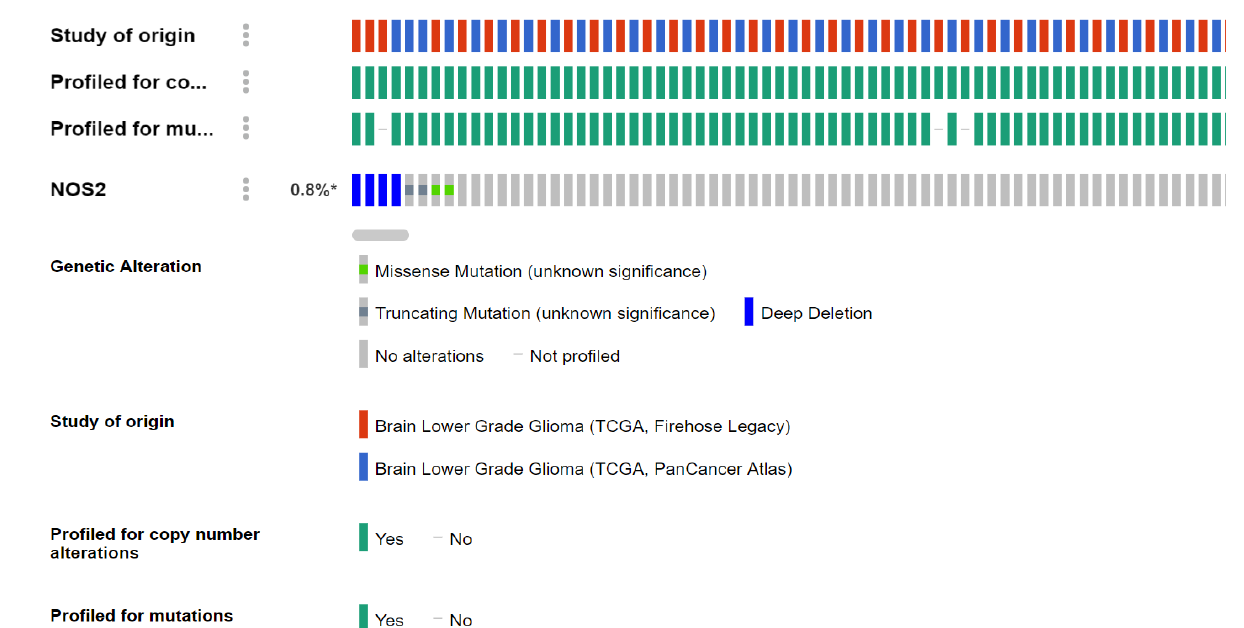
Figure 3: Scatter plot of iNOS/NOS2 mRNA expression levels in tumor tissues and normal brain tissues of glioma patients.